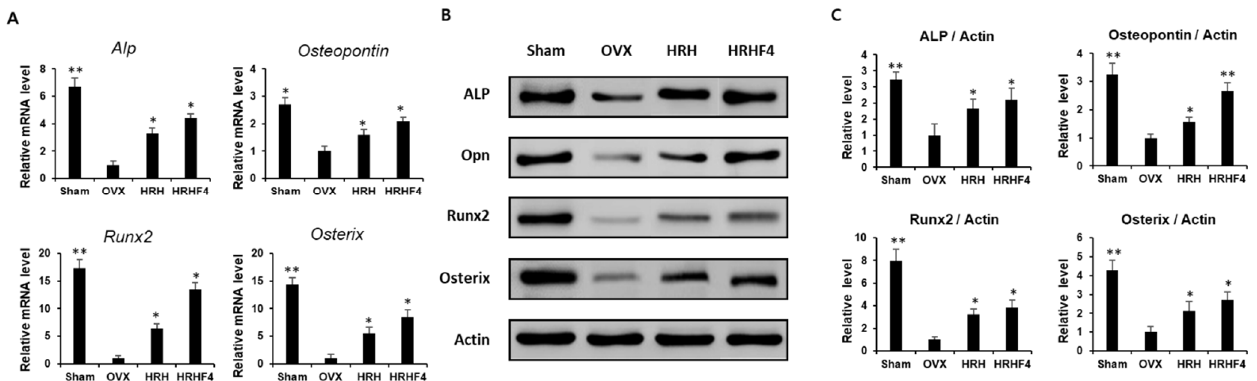
Figure 5. Expression of osteogenic mRNAs and proteins in mouse tibia samples. ( A ) Relative osteogenic mRNA expression of Alkaline Phosphate (ALP) , Osteopontin (OPN) , Runx2 , and Osterix in each sample, obtained by pulverizing the both tibia of each mouse after animal sacrifice. ( B ) Protein expression of osteogenic genes including ALP , OPN , Runx2 , and Osterix, and β -actin , a housekeeping gene in each sample, were obtained by pulverizing both the tibiae of each mouse after animal sacrifice. ( C ) The expression shown through Western blot results was quantified through the ImageJ (Java) software. * denotes p < 0.05, ** denotes p < 0.01 vs. OVX control, determined by the least significant difference test compared to level of β -actin , a housekeeping protein expression. OVX, bilateral ovariectomy; HRH, Hexane-soluble fraction from ethanol extract of H. rhamnoides fruits; HRHF4, Hexane-soluble fraction number 4 from ethanol extract of H. rhamnoides fruits.